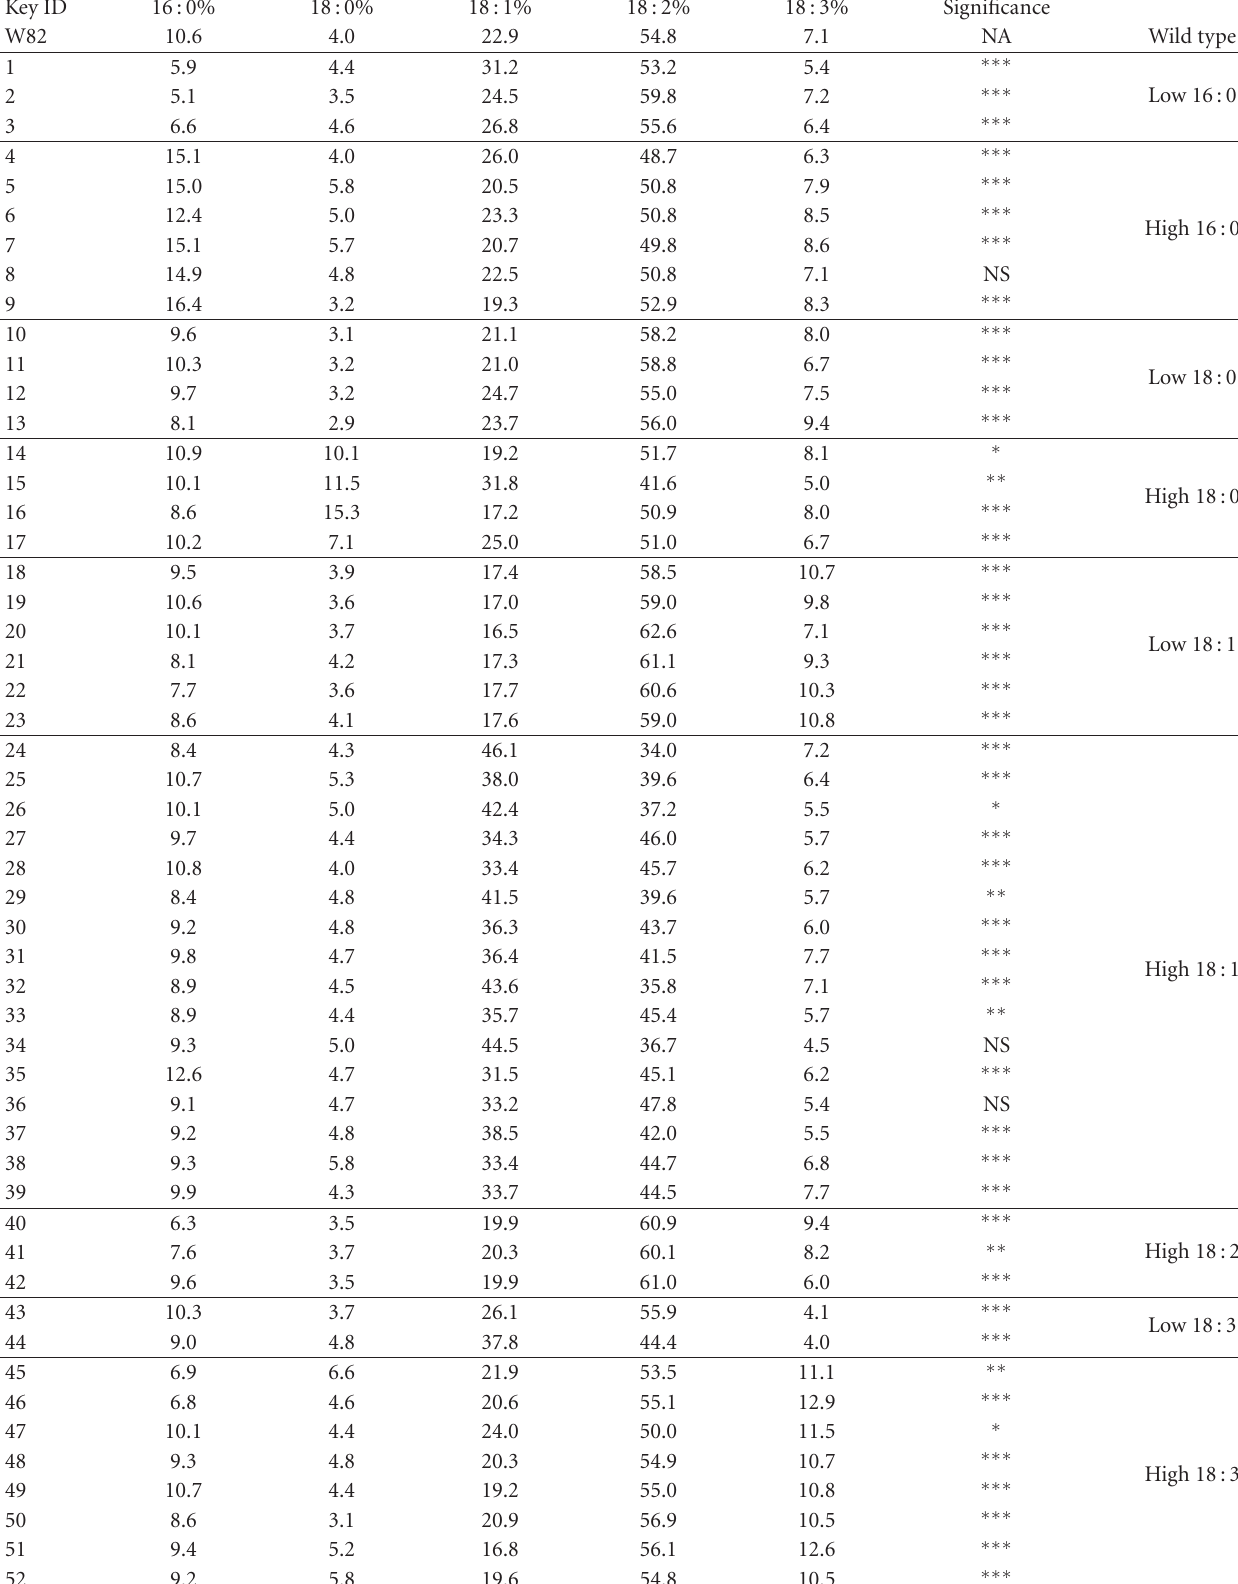
Table 1: Complete fatty acid profiles for selected M 3